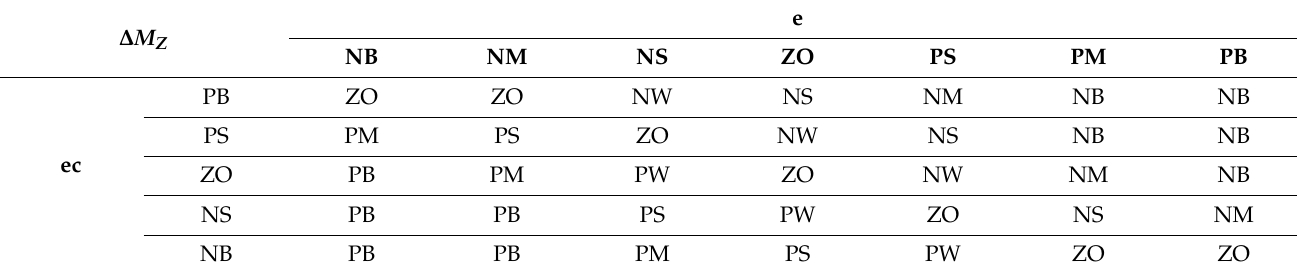
Table 3. Fuzzy control rule